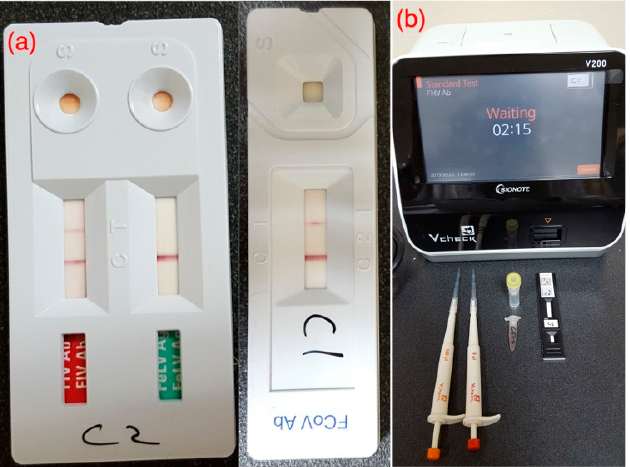
Figure 3. ( a ) Qualitative snap tests and ( b ) Vcheck-V200 machine for semi-quantitative IgG immunoassays. Table 6. Viral screening results through qualitative snap tests and semi-quantitative IgG immunoas- says in a total of 27 (22 shelter and 05 privately owned) cats manifested acute/chronic infectious Table 7 indicates the complete sequel of individual sample collected from all 34 cats respiratory disease signs. with final outcome. Tracheal and nasal swabs were collected from shelters’ cats while only nasal swabs from privately ‐ owned cats for URT infection(s). Similarly, lung swabs were collected from shelters’ cats while pleural effusions from privately ‐ owned cats. A total of 62% ( n = 21) samples from URT and 38% ( n = 13) samples from LRT produced some kind of bacterial growth(s) on blood agar. Same swabs were used on MacConkey agar and pro ‐